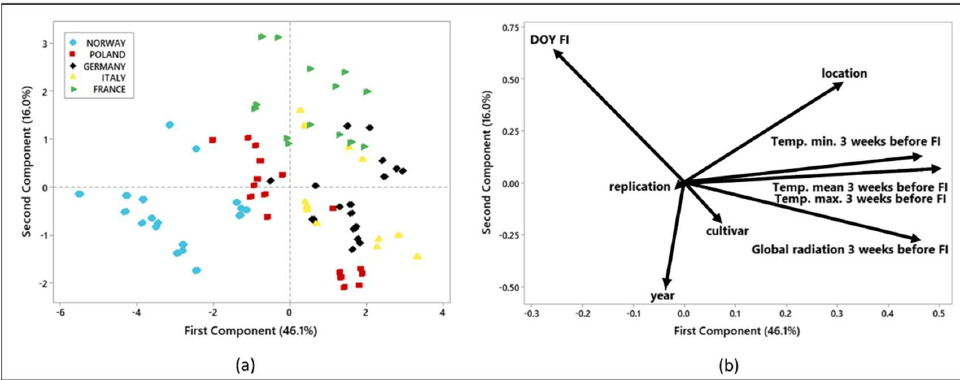
Figure 2. Principal component analysis (PCA) based on the correlation matrix of the day of the year for strawberry flower initiation (DOY-FI) and climatic variables during the 3-week period preceding flower initiation. Score plot ( a ) and loading plot ( b ).